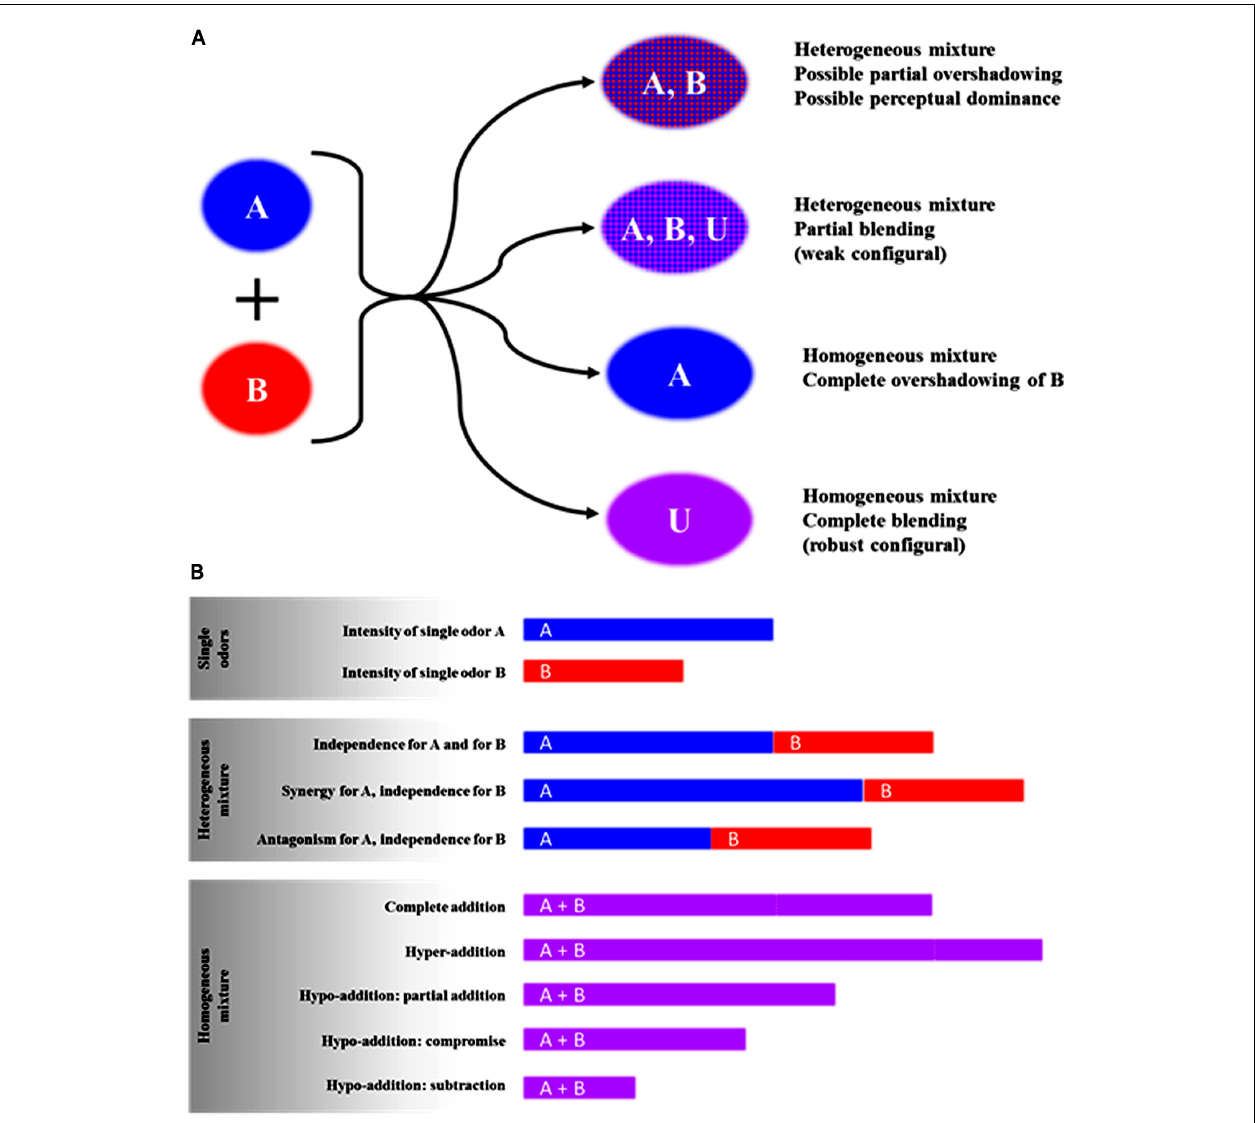
FIGURE 1 |Theoretical outcomes on odor quality (A) and odor intensity (B) when two odorants are perceived in the mixture. One odorant has an odor noted A and the other B, while odor U is specific to the mixture (Unique-cue, see section on configural processing of odorants in mixtures) (this figure was partially adapted fromThomas-Danguin